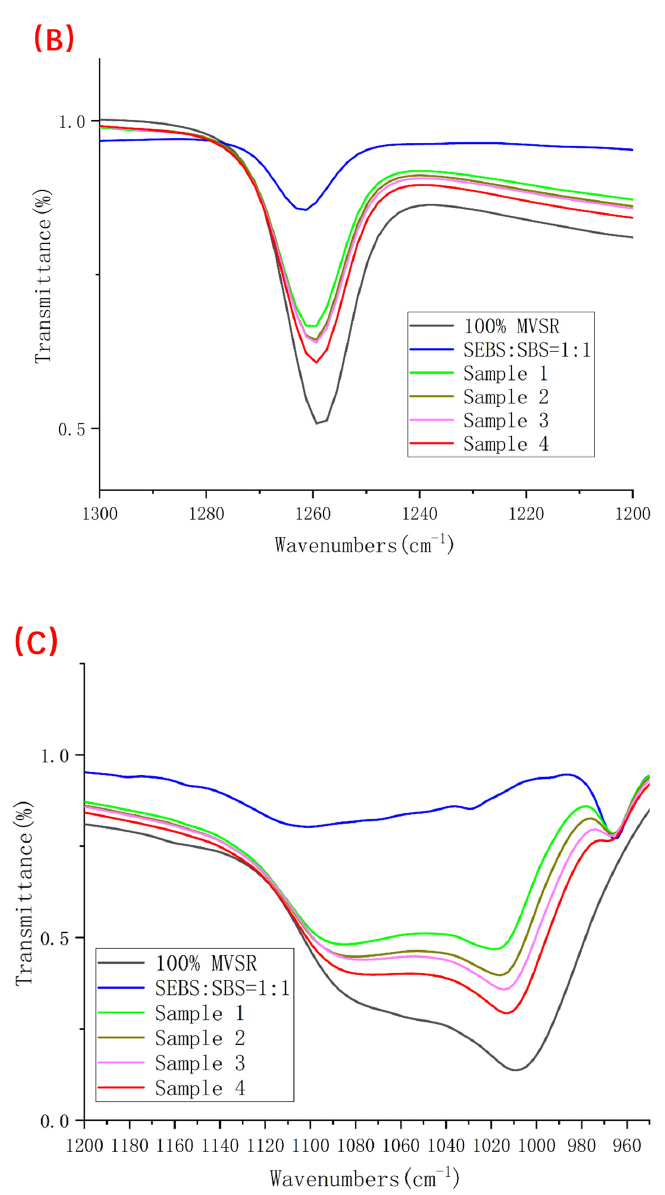
Figure 8. FI-IR diagrams of 100% MVSR, 50% SEBS + 50% SBS and samples 1–4. ( A ) Complete spectrum; ( B ) Enlarged detail near wavenumber 1260 cm − 1 ; ( C ) Enlarged detail near wavenumber 1010 cm − 1 . Table 3. Peak wave numbers of FI-IR diagrams of 100% MVSR, 50% SEBS + 50% SBS and samples